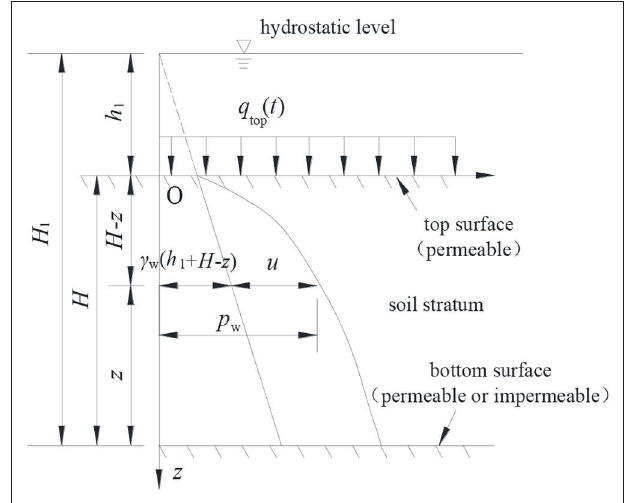
FIGURE 1 | Schematic diagram of the one-dimensional consolidation model of the foundation.